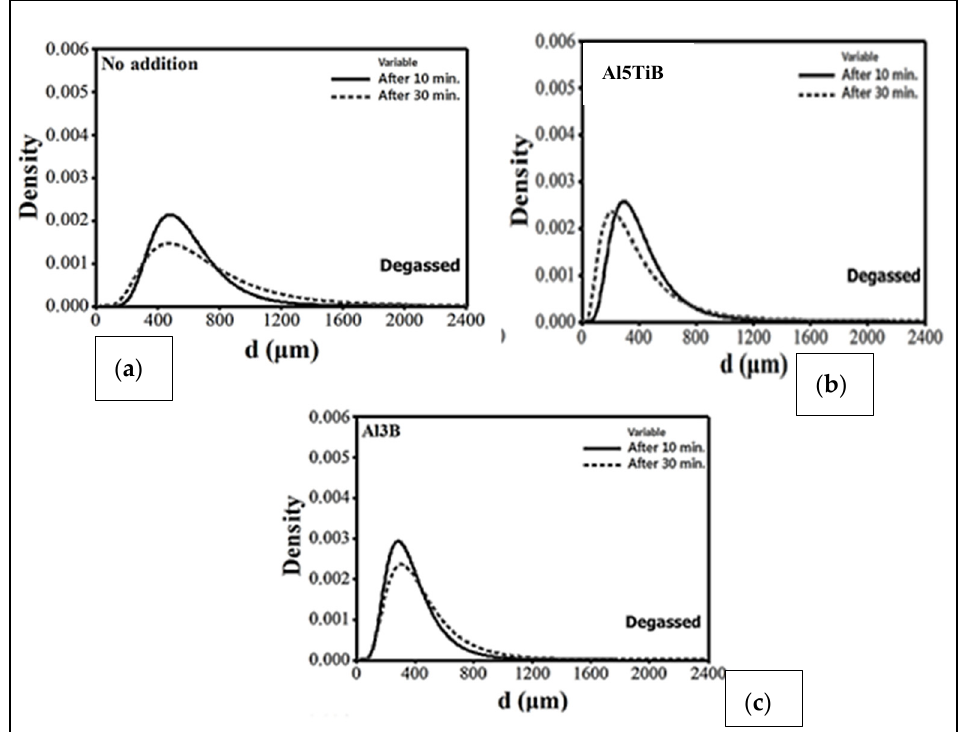
Figure 14. Lognormal distributions of pore sizes in Al-7%Si-0.35%Mg (A356) alloy after 10- and 30-min holds: ( a ) for non-treated alloy; ( b ) with Al-5Ti-1B addition; ( c ) with Al-3B addition. In all cases, the alloy melts were degassed to avoid entrapment of oxide films.